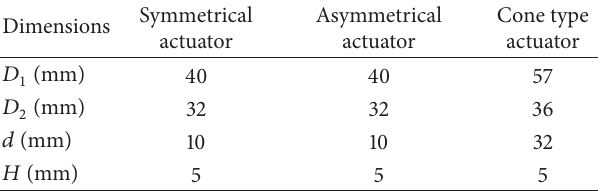
Table 2: Dimensions of the